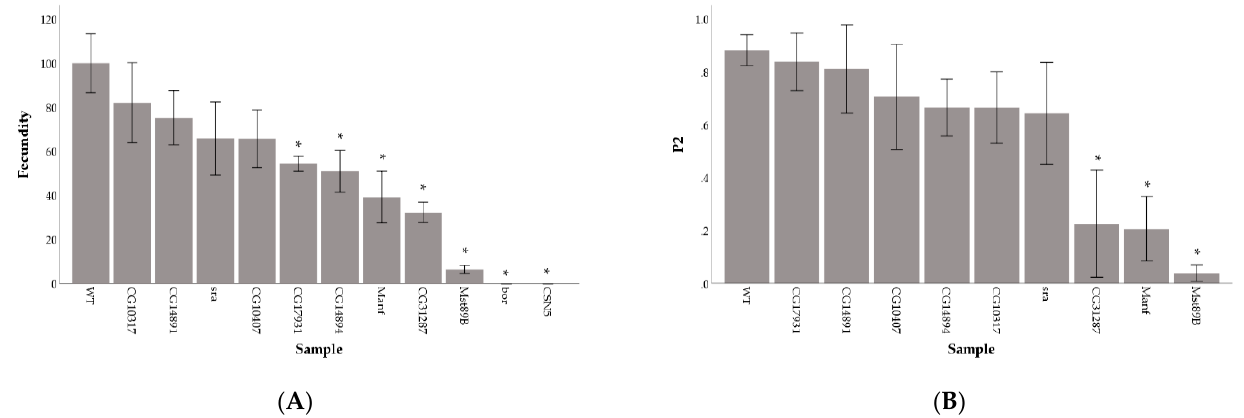
Figure 1. Average fecundity ( A ) and second male paternity success ( B ) for gene knockdowns compared with the wild-type (WT) control. Asterisks (*) above bars identify samples with averages significantly different from the wild-type control. Error bars are 2 standard errors of the mean.